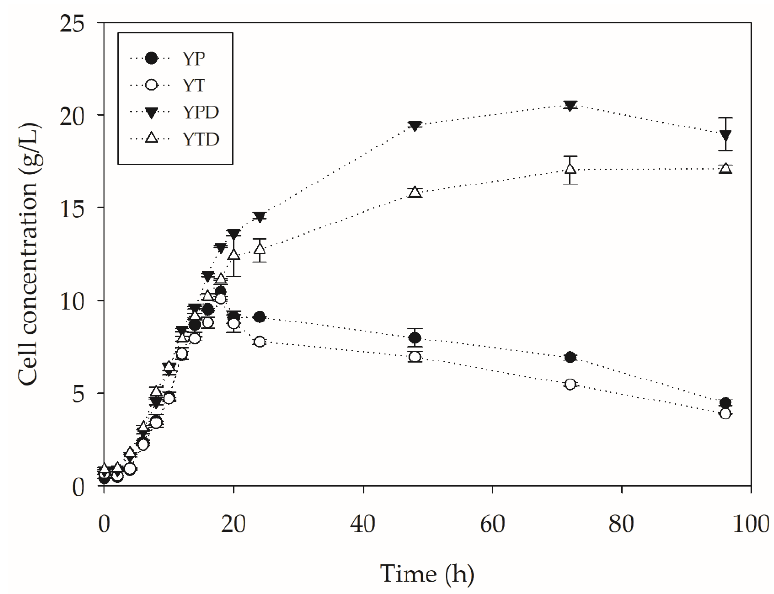
Figure 2. Growth of Y. lipolytica IMUFRJ 50682 in different media containing PET-PC (500 mg/L) at 28 °C and 250 rpm for 96 h.